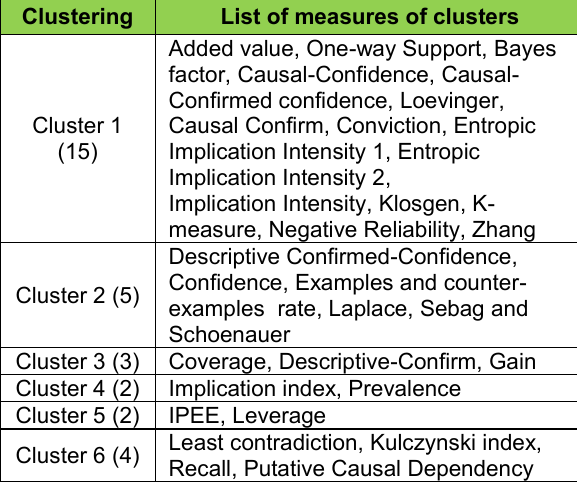
Table 2: The clustering results of measures based on Euclidean distance (h=2).